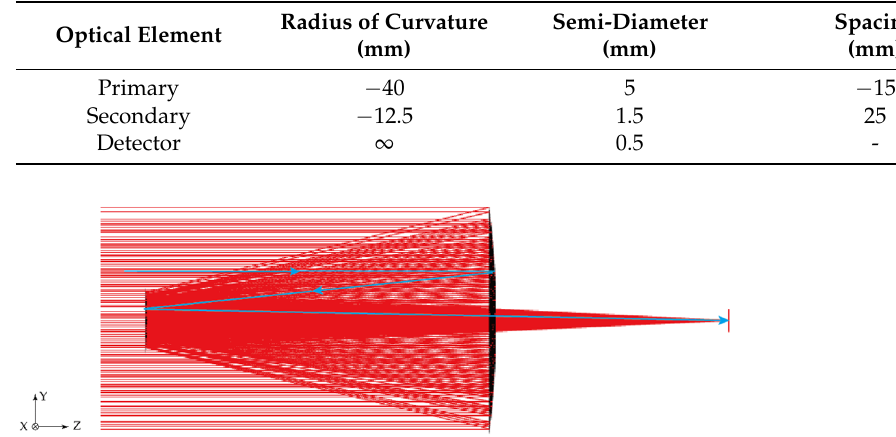
Table 2. Optical configuration of a typical Cassegrain system.